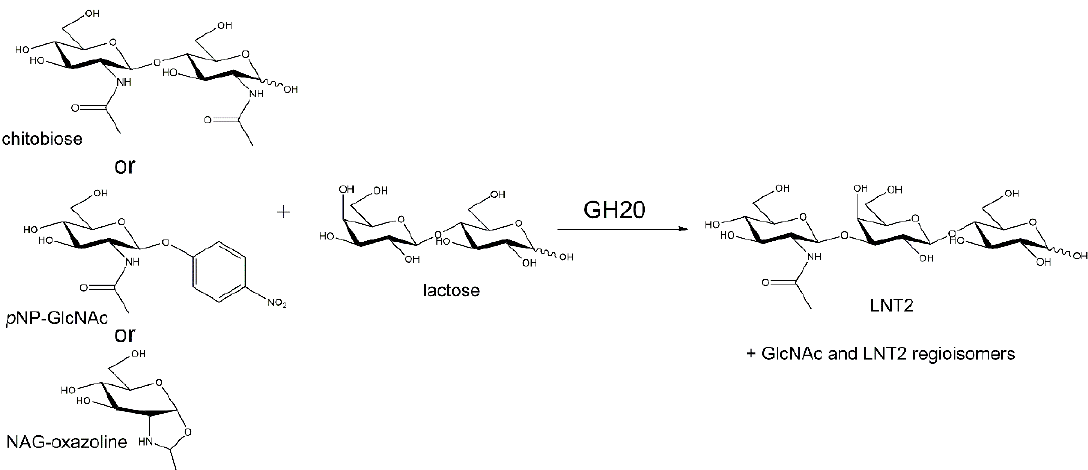
Figure 6. Scheme of transglycosylation reactions catalyzed by GH20 enzymes showing three different possible donors and lactose as an acceptor.